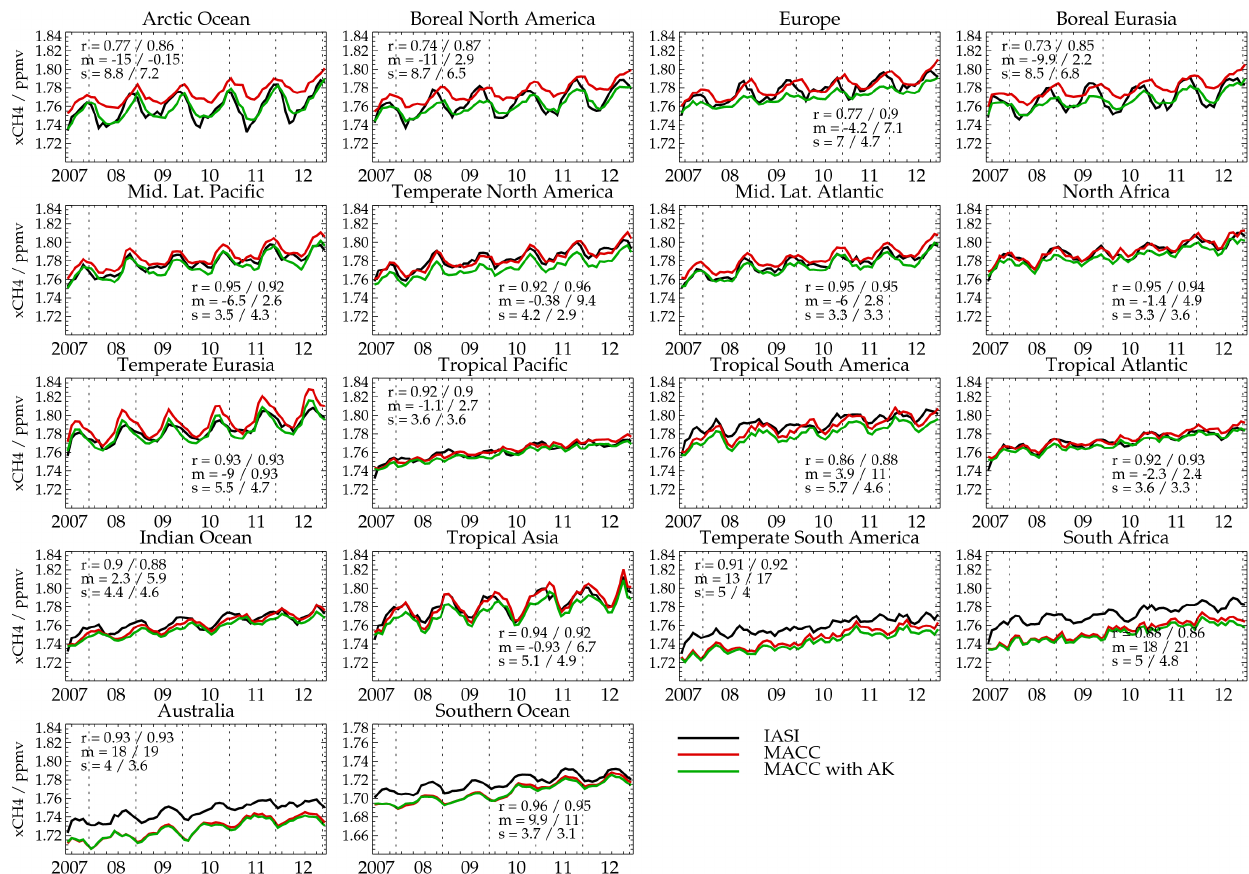
Figure 10. Time series of monthly, regionally averaged column-averaged methane from IASI and MACC. IASI measurements are shown in black; values directly from MACC are in red; MACC results after applying the IASI averaging kernel (AK) are shown in green. The caption in each panel indicates the correlation between IASI and MACC ( r ), the mean difference IASI − MACC ( m ) in ppbv and the SD in the difference ( s ) in ppbv. Two values are given in each case, first for the direct IASI–MACC comparison and then after applying the kernels. Dashed vertical lines mark the beginning and end of each